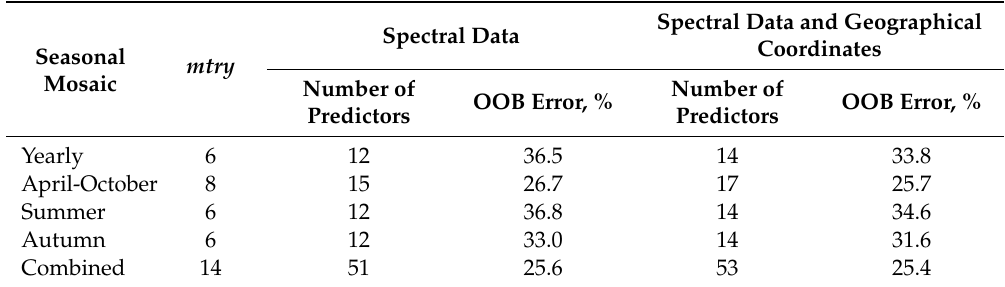
Table 2. Accuracy assessment analysis of land cover classification using di ff erent seasonal